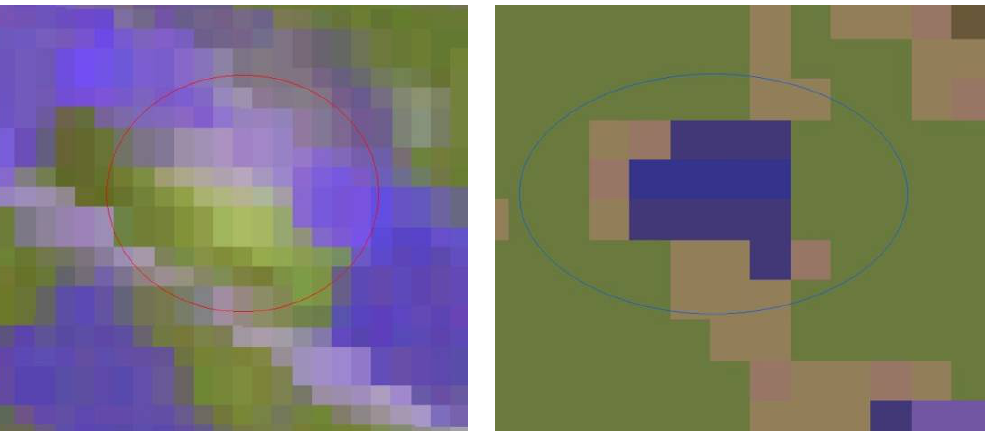
Figure 15. Original ASTER (RGB → 1,2,3) image indicating the Galini 4 settlements (left) and the same area after the application of De-correlation Stretch (right).